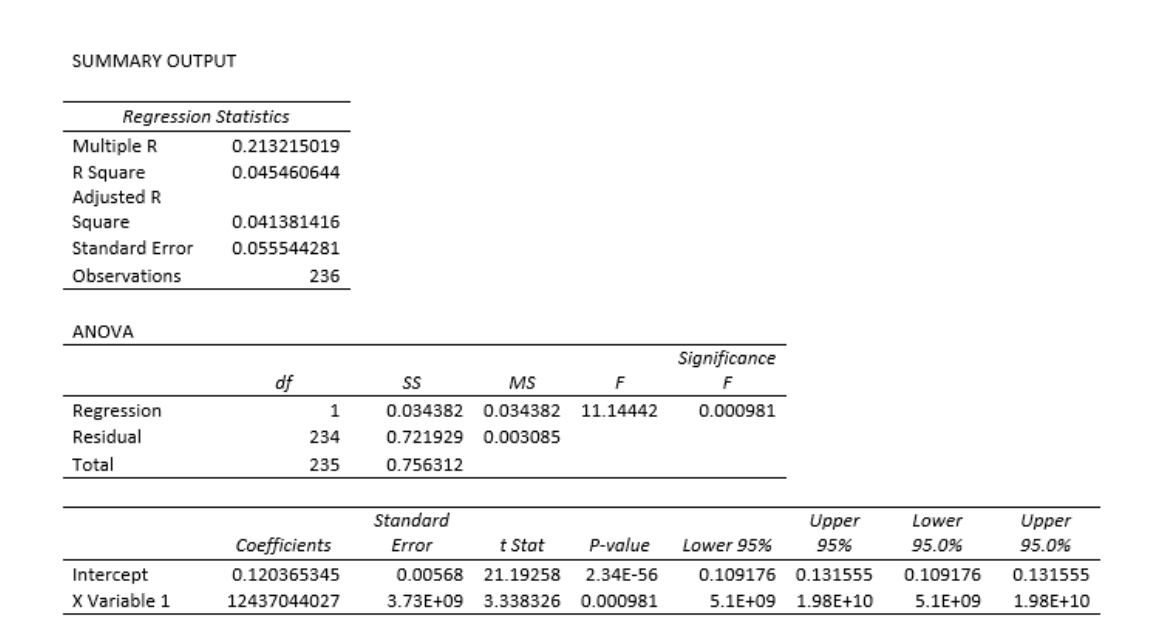
Figure 5. Analysis summary for chlorophyll prediction from MERRA II dry deposition.